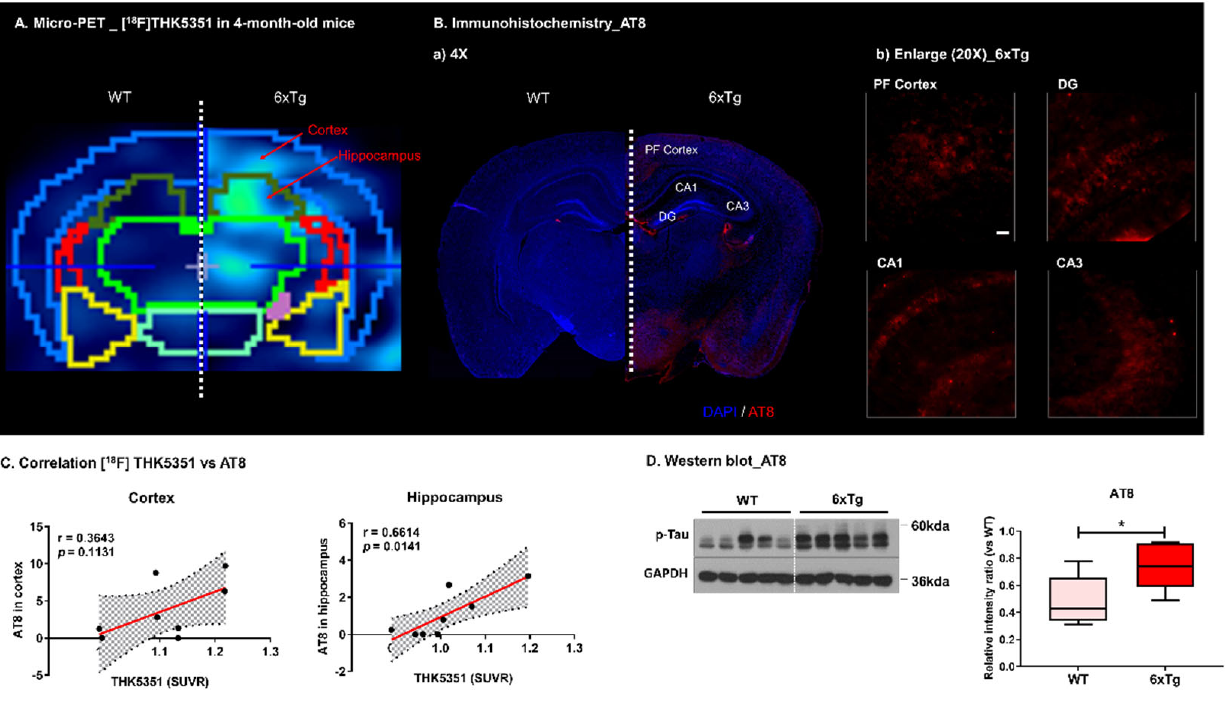
Figure 5. Representative images of [ 18 F]THK5351 and AT8 immunostained images in brain. ( A ) The [ 18 F]THK5351 intensity of 4 ‐ month ‐ old 6 × Tg mice was increased in the cortex and hippocampus compared with WT. ( B ) Immunostained brain tissues with AT8 antibody of 4 ‐ month ‐ old 6 × Tg and WT mice brains. Counterstained with DAPI. Representative slices are shown for (a) WT and 6 × Tg mouse brains (4× magnification) and (b) cortex (PF) and hippocampus (DG, CA1, and CA3) regions of 6 × Tg mice brain (20× magnification) (all scale bars = 100 μ m). AT8 ‐ immunoreactive p ‐ Tau were